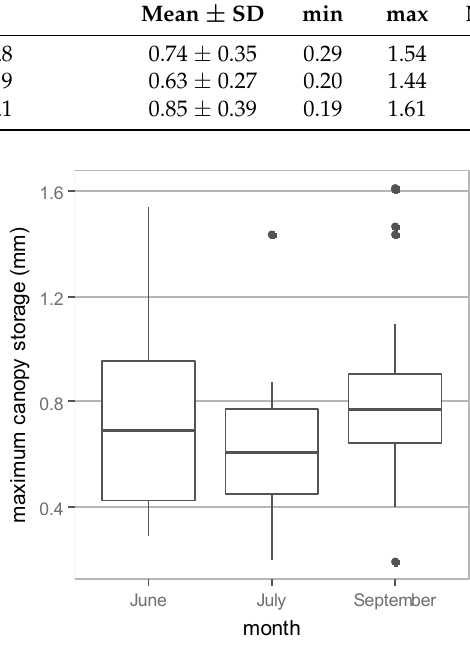
Figure 4 . Measured values of maximum canopy storage for the three field campaigns. Figure 4. Measured values of maximum canopy storage for the three field